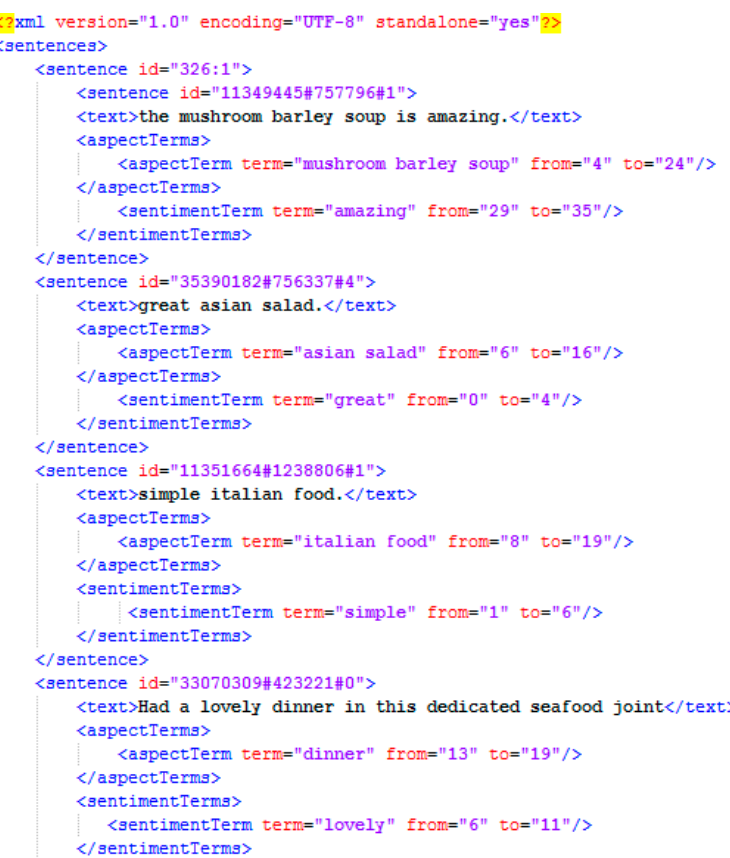
Figure 5. Annotated testing dataset for the restaurant domain.